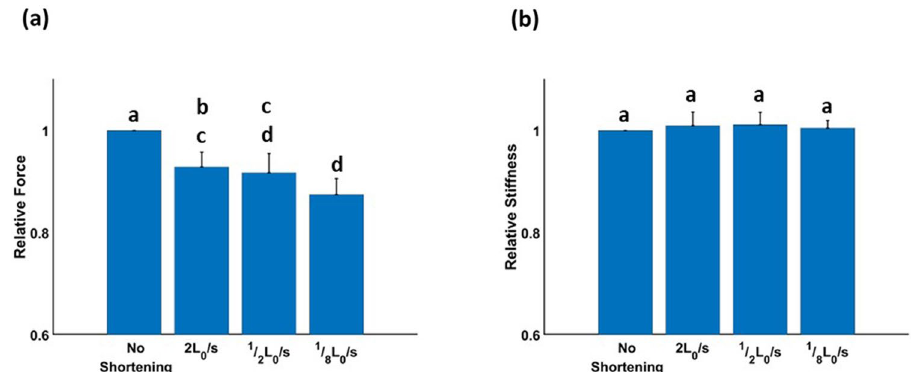
Figure 2. Relative isometric force and stiffness after 1000 ms of active shortening. ( a ) Mean relative isometric forces after active shortening were lower than pure isometric force (HSD, p < 0.05). The fastest active shortening velocity produced a larger mean relative force than the slowest active shortening velocity (HSD, p < 0.05), demonstrating less residual force depression in the fastest active shortening velocity than in the slowest active shortening velocity. ( b ) Mean relative muscle stiffness after active shortening did not differ significantly among shortening velocities (ANOVA, F = 0.37, p < 0.77). Bars with the same letter are not significantly different (HSD, p >